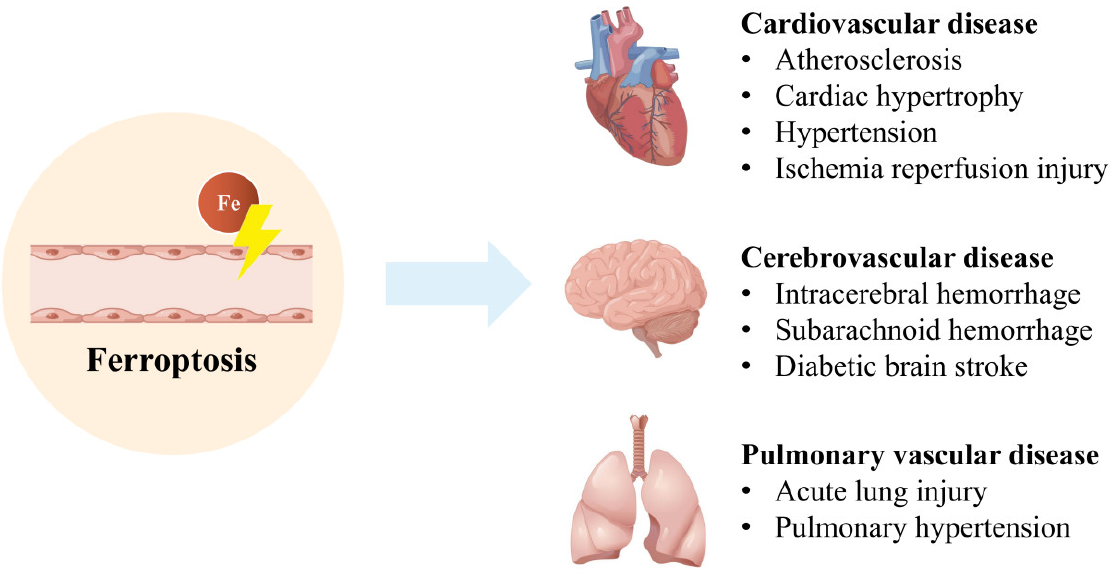
Figure 2. Ferroptosis of ECs is related to multiple vascular diseases, such as AS, stroke, ALI, and so on. Modified from Figdraw (www.figdraw.com, accessed on 22 May